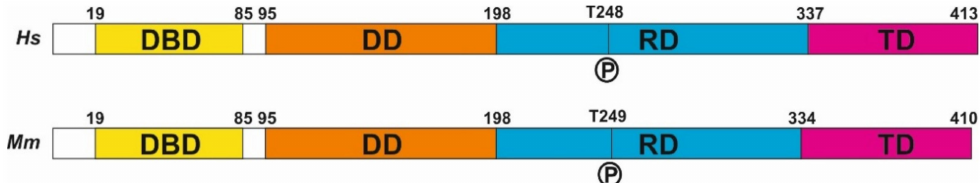
Figure 1. E2F4 structure. The structure of human ( Hs ) and mouse ( Mm ) E2F4, derived from NCBI Reference Sequences NP_001941.2 ( H. sapiens ) and NP_683754.1 ( M. musculus ). DBD: DNA